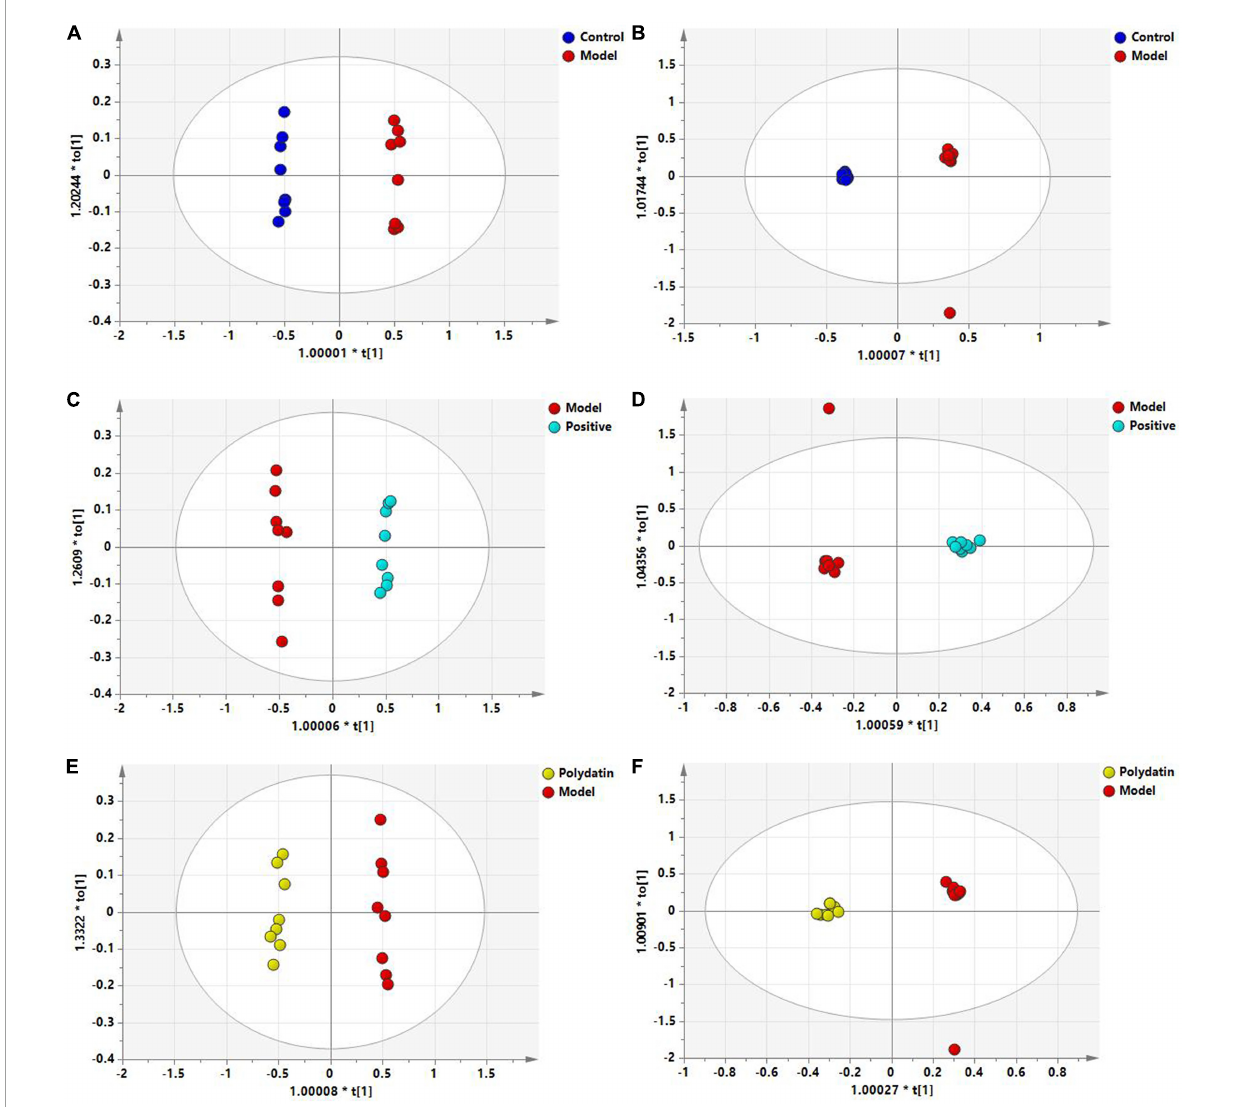
FIGURE4 OPLS-DA score plots of serum samples in different groups. Control and model groups in ESI + mode (A) and ESI- mode (B) ; positive and model groups in ESI + mode (C) and ESI − mode (D) ; polydatin and model groups in ESI + mode (E) and ESI − mode (F)